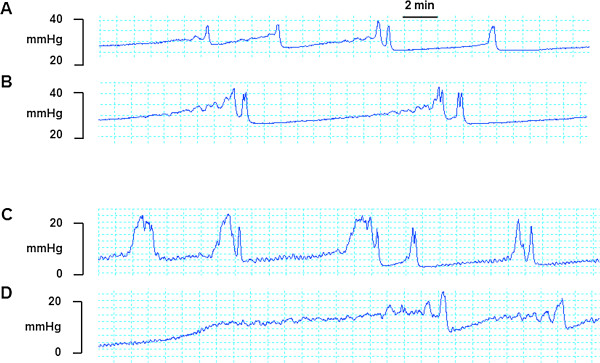
Raw traces of representative cystometric pressure recording (mmHg) before (A and C) and during threshold intensity of spinal nerve stimulation (B and D) at 10 Hz, pulse width 0.1 ms in saline- (A and B) or acetic acid- (C and D) infused rats.